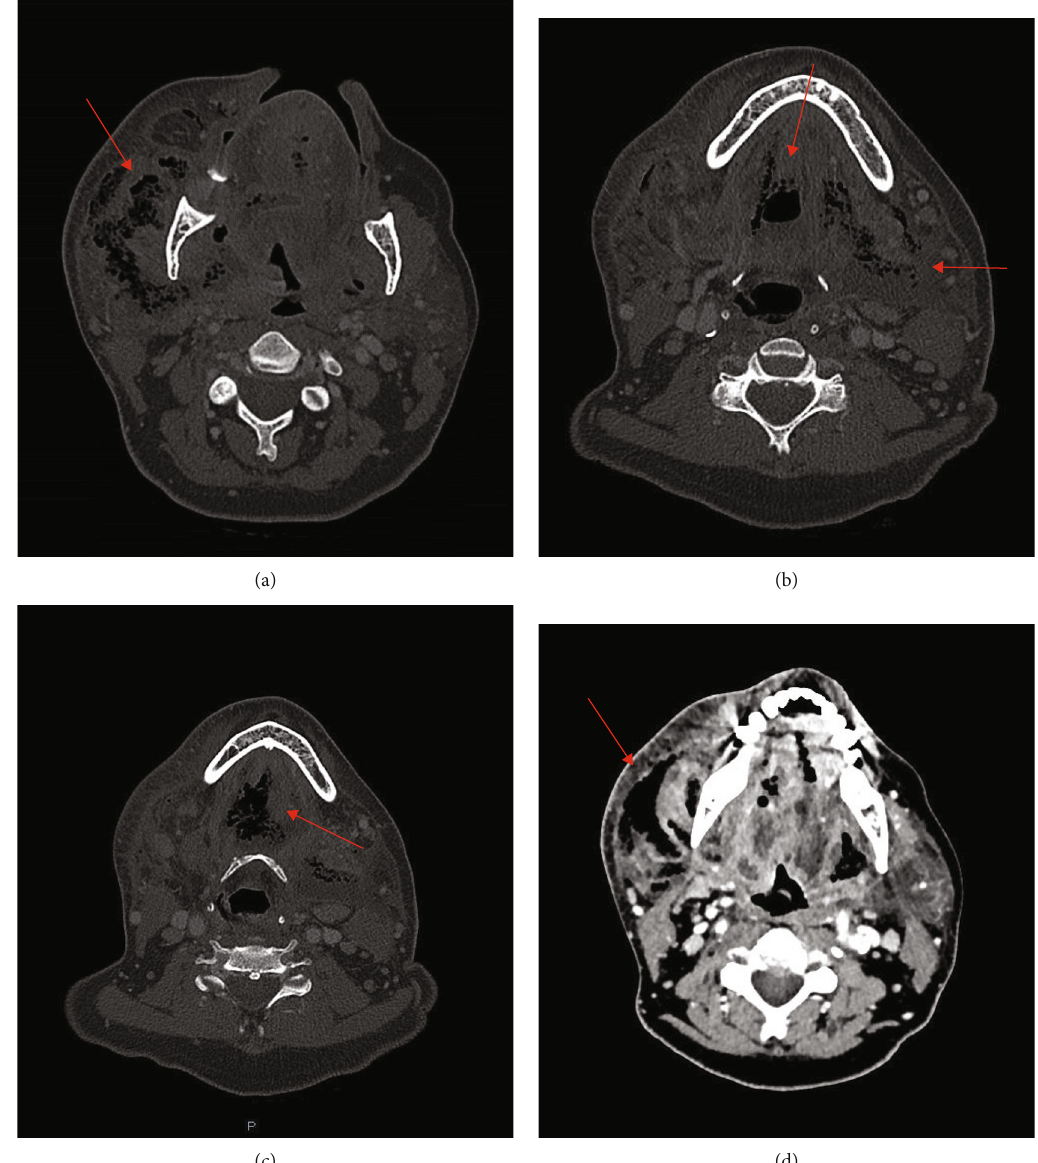
Figure 4: (a – d) Initial CT of the neck (transverse plane) highlighting the presence of gas bubbles (red arrows): at the right parotid gland posteriorly (a); oral fl oor extending up to the contralateral parotid capsule (b); sternocleidomastoid muscle medially and the thyroid space inferiorly (c); at the right parotid gland in a di ff erent cutting plane height (d)